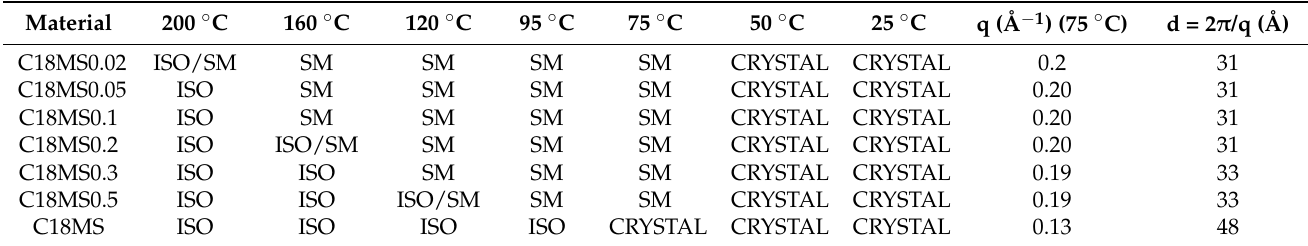
Table 2. Summarized phases (ISO = isotropic, SM = smectic, and CRYSTAL = crystalline) of blended electrolytes containing C18MS as shown through SAXS and WAXS measurements at each measure- ment temperature while cooling. Values of the scattering vector for the first major peaks and the corresponding d-spacing values at 75 ◦ C are also shown.